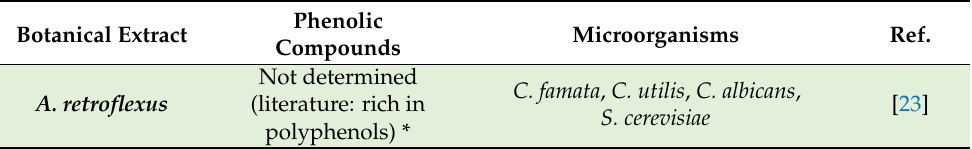
Table 3. Phenolic-rich extracts which have demonstrated antifungal activity against fungal clini- cal